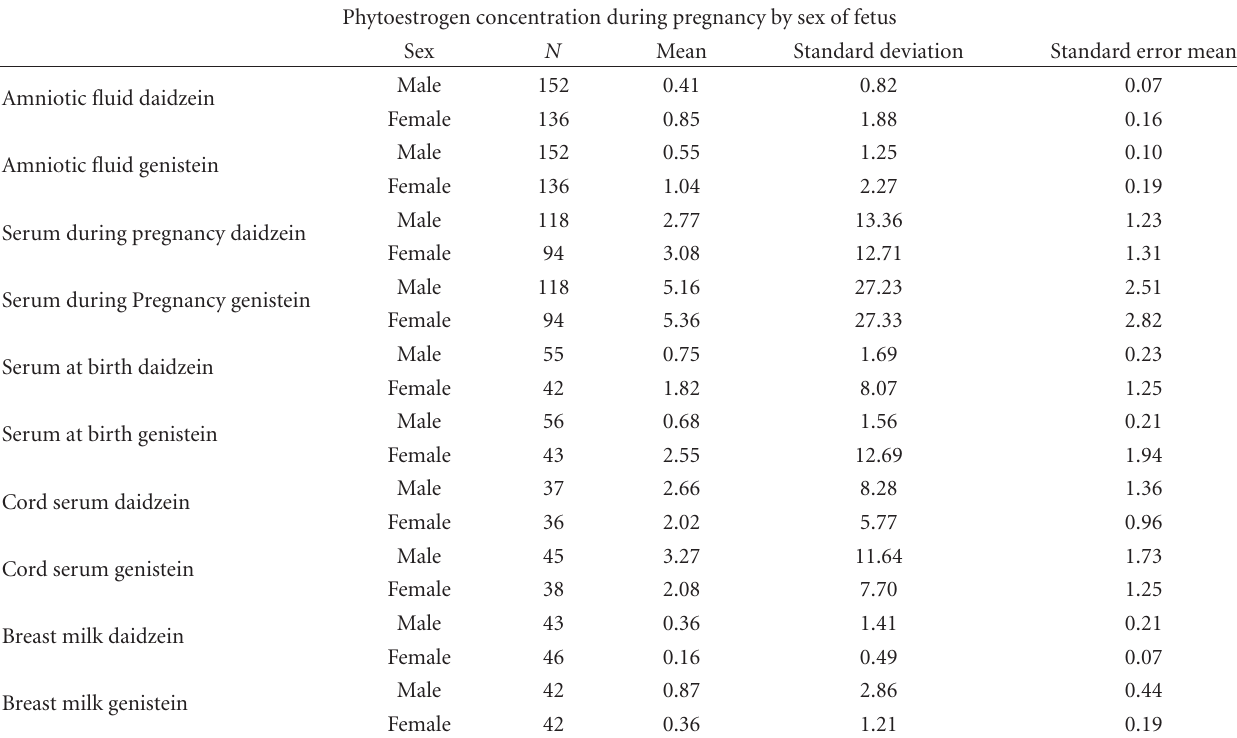
Table 3: Phytoestrogen concentration during pregnancy by sex of fetus. Phytoestrogen concentration during pregnancy by sex of